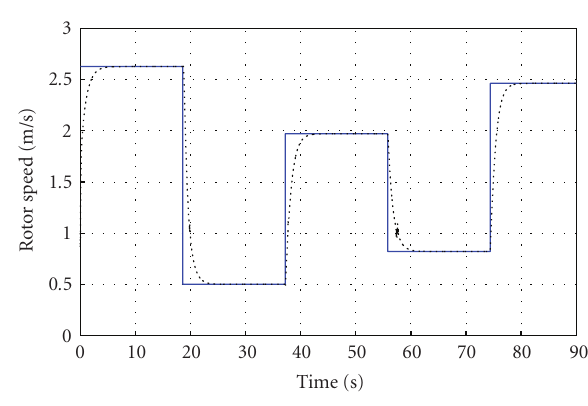
Figure 15: Rotor speed tracking.